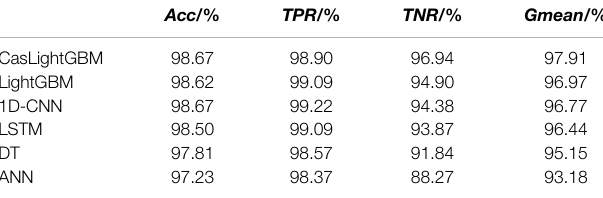
TABLE 3 | Comparison of different machine learning